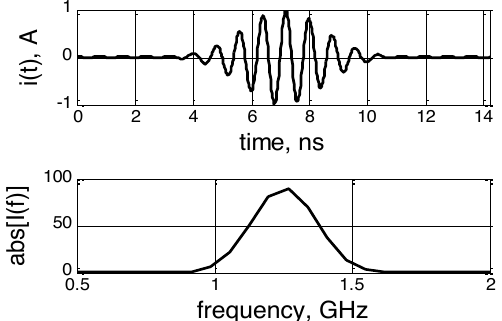
Figure 26: Transient current excitation signal (in top) and the corresponding spectrum (in